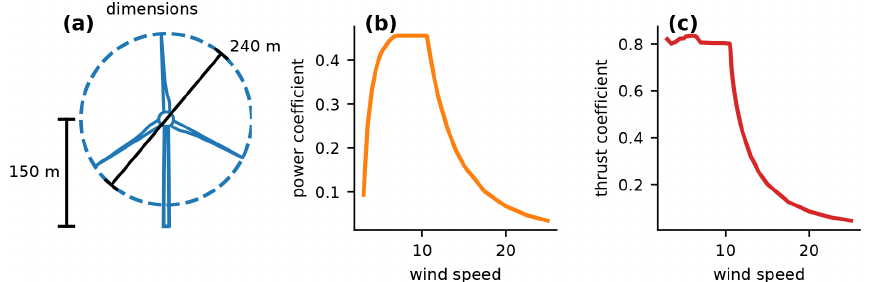
Figure 1. Parameters of the 15MW wind turbine used in this study. From left to right, this figure provides the important wind turbine dimensions, the power coefficient curve, and the thrust coefficient